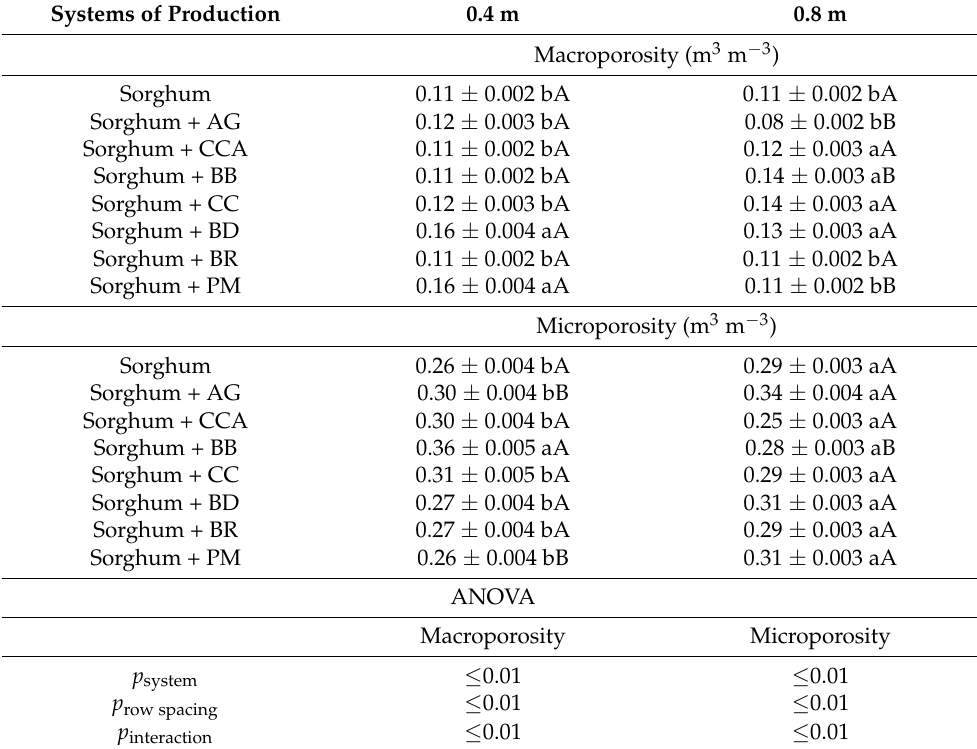
Averages with the same lowercase (intercropping; lines), and uppercase letters (row spacing; columns) belong to the same grouping, according to the Scott-Knott test (1% probability). Averages are represented with an equivalent standard deviation of the